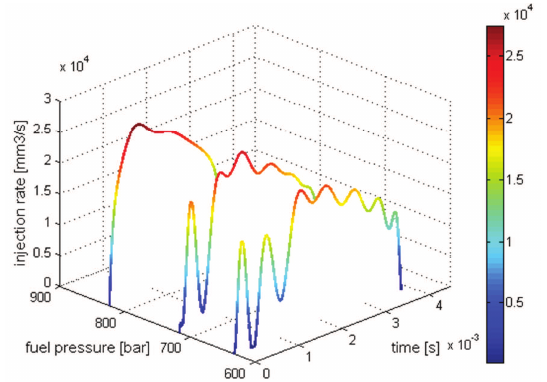
Fig. 2. Injection courses of the doses with constant value (second measur- ing group)